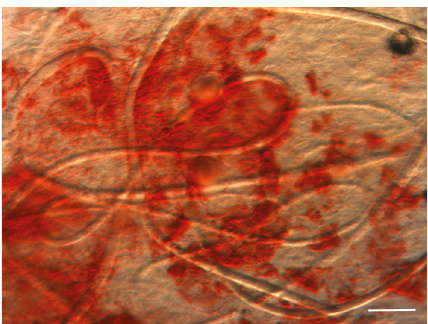
Figure 1: Vellus hairs present in cysts from clinical presentation case #1, a 15-year-old male patient. Cyst contents were expressed via incision and drainage and mounted with a coverslip without KOH. Scale bar = 100